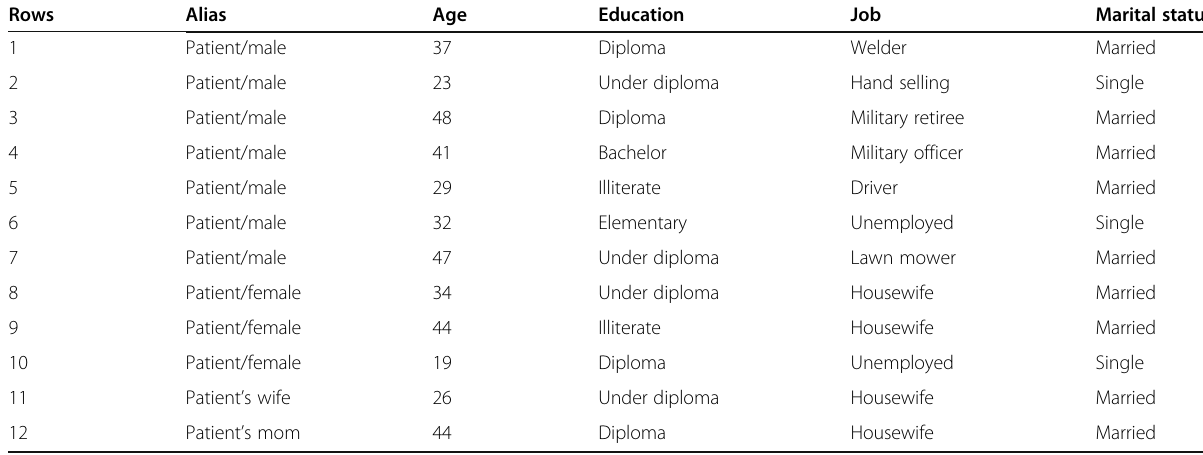
Table 2 Demographic characteristics of the participants